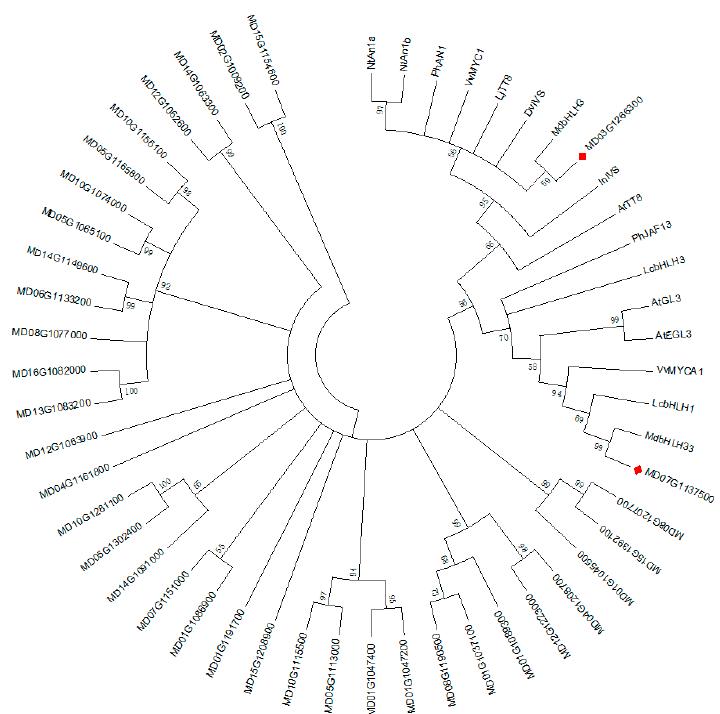
Figure 8. Phylogenetic analysis of the bHLH genes in M . ‘Profusion’ and the bHLH genes known to regulate anthocyanin biosynthesis in other plant species. GenBank accession numbers are as follows: NtAn1a (AEE99257), NtAn1b (AEE99258), PhAN1 (AAG25927), VvMYC1 (ACC68685),